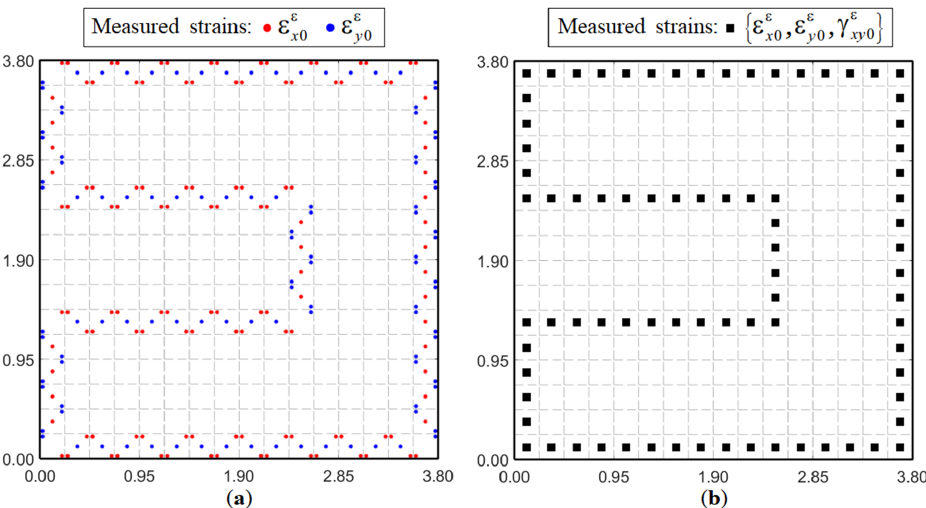
Figure 10. In-situ strain measurements and their locations corresponding to: ( a ) Unitcell-1, and ( b ) Unitcell-2.